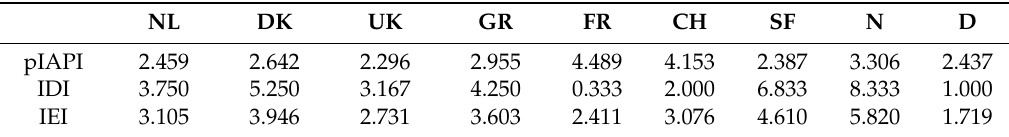
Table 5. Calculated indoor air quality (IAQ) indexes for 56 European office buildings averaged per country.